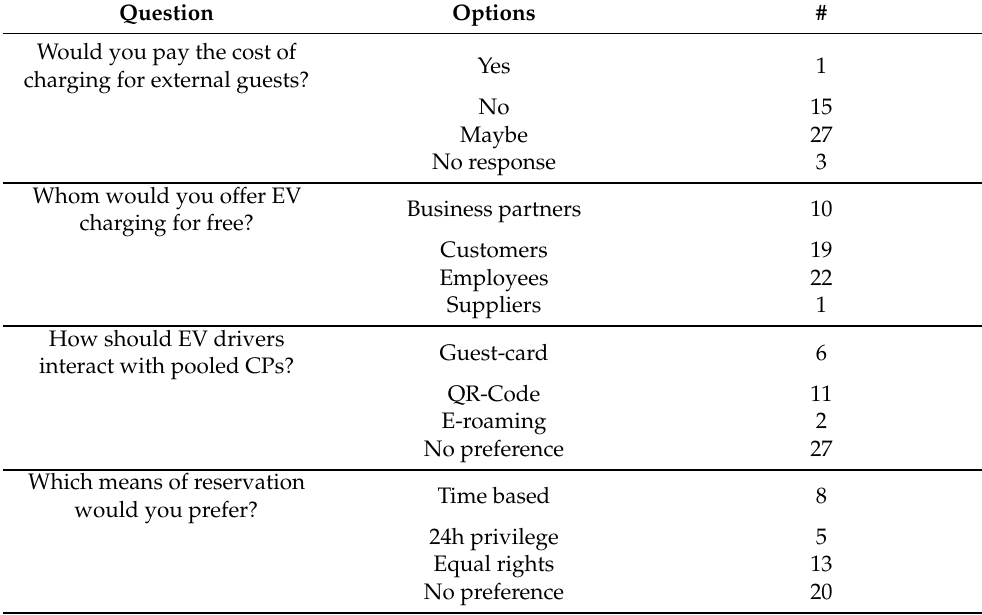
Table 1. Summary of company